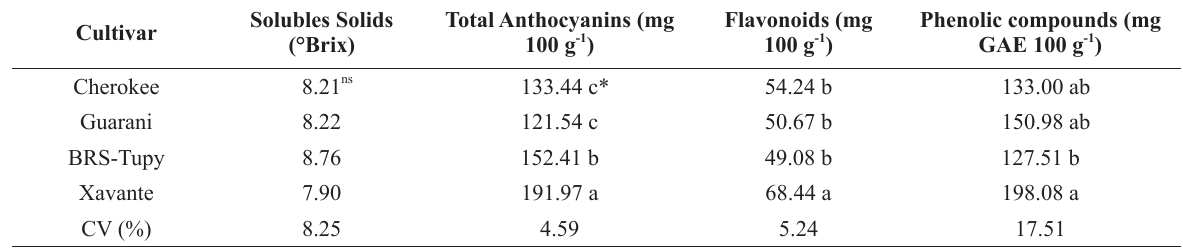
Chemical analysis of solubles solids, total anthocyanins, flavonoids and phenolic compounds for the different cultivars of Blackberry. Chapecó, SC, 2018.